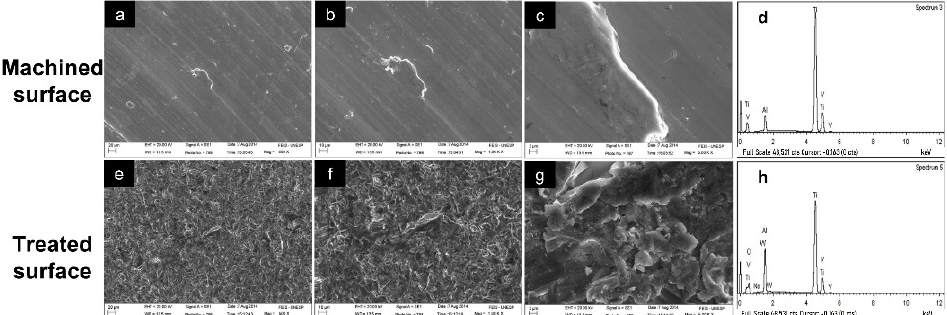
Figure 5. Topographic surface analysis of machined and treated surface implants prior to experi ‐ mental surgery: ( a )–( c ) SEM: machined surface, 500×, 1000× and 5000×; ( d ) EDX: machined surface; ( e )–( g ) SEM: treated surface, 500×, 1000× and 5000×; ( h ) EDX: treated surface.